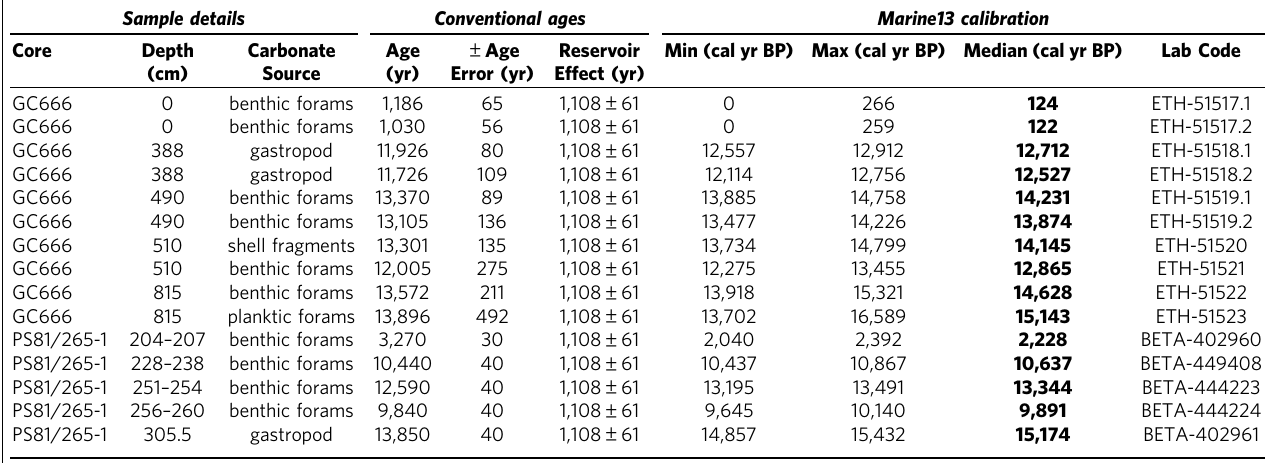
Table 1 | Radiocarbon age determinations for cores PS81/265-1 and GC666, from the South Georgia